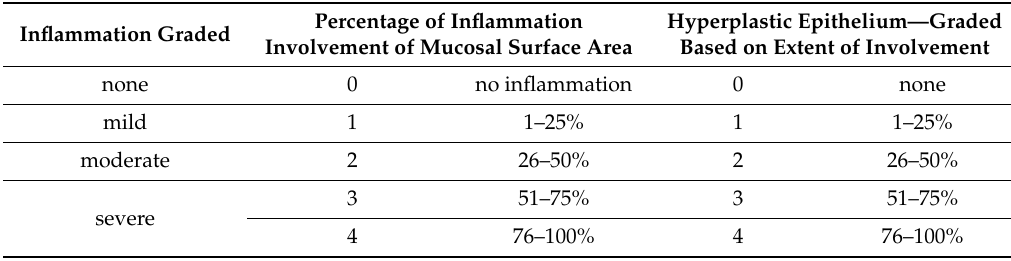
Table 2. Colon tissue histological examination Crypt aberration score.